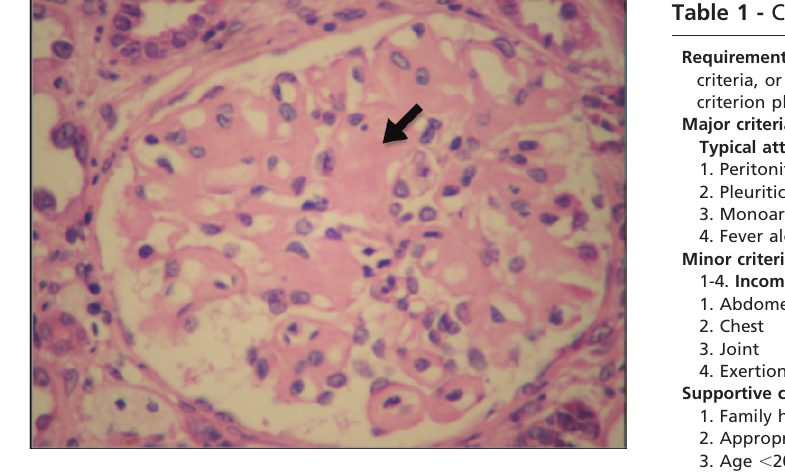
Figure 1 - Kidney biopsy, hematoxylin-eosin, and light micro- scopy. Enlarged hypocellular glomerulus with deposits of amorphous material ( arrow ). Magnification 300x.